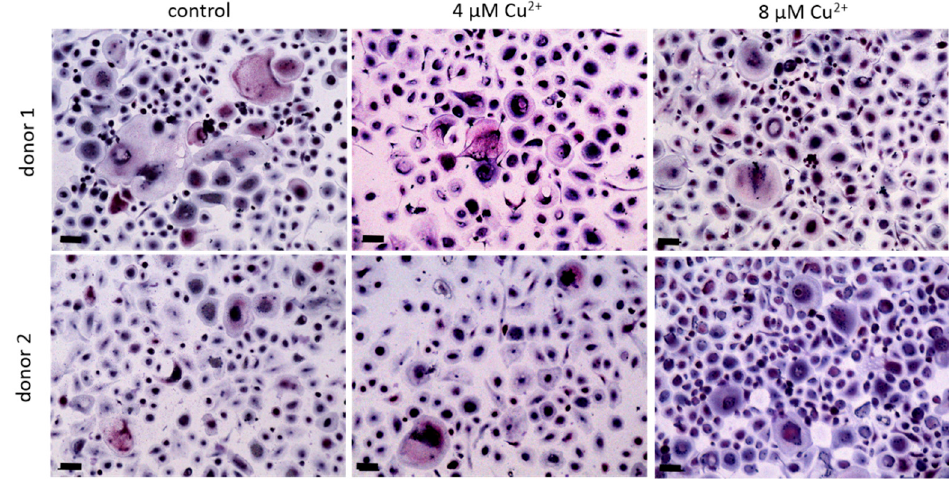
Figure 7. Osteoclasts were differentiated from PBMC for 10 days in the presence of MCSF and RANKL, detached and cultivated for further 4 days without Cu 2+ (control) as well as under the addition of 4 and 8 µM Cu 2+ , light microscopy after staining of TRAP (pink) and nuclei (blue), scale bars represent 100 µm.